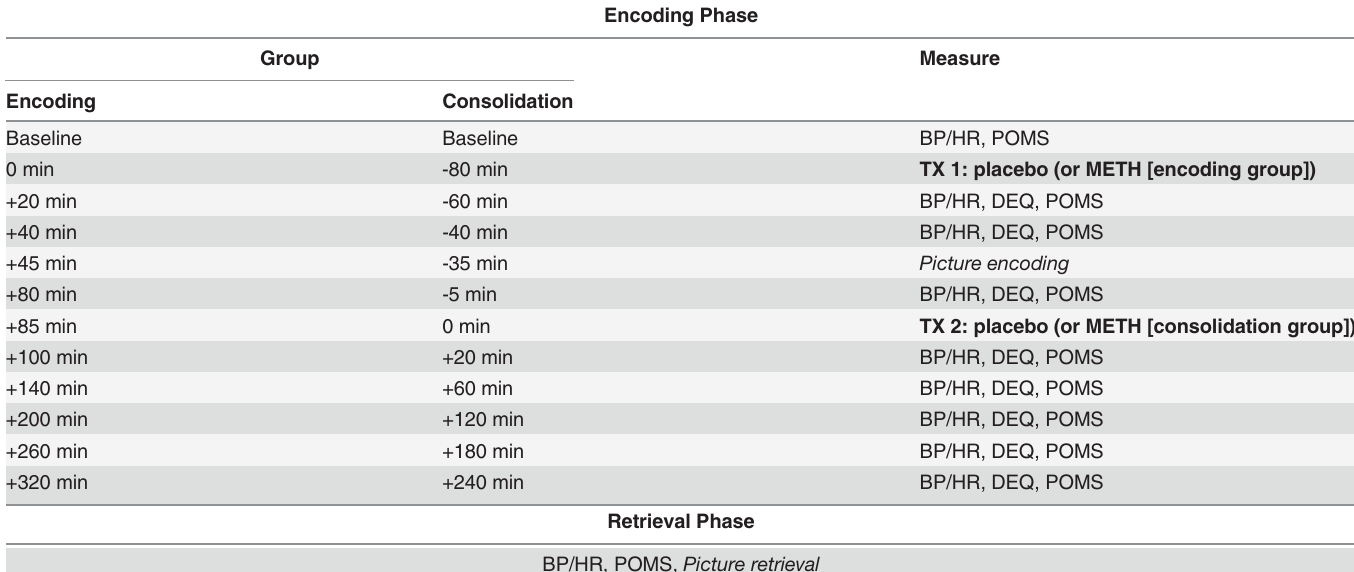
Table 1. Timeline of a single experimental session for encoding and consolidation